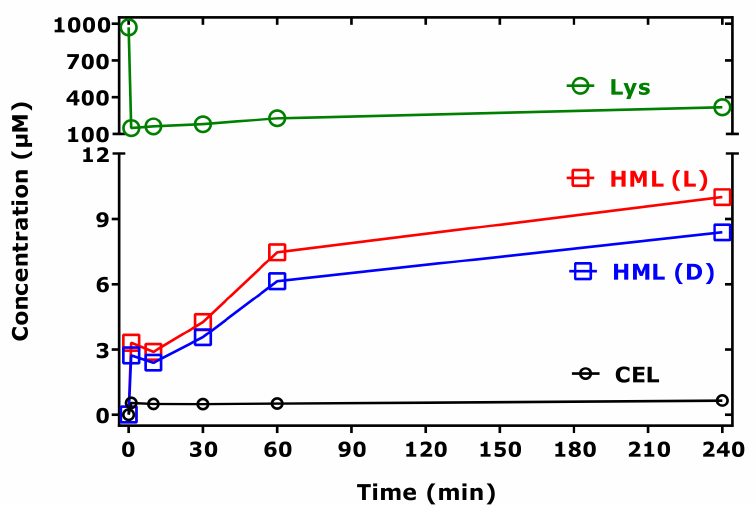
Figure 6. Time-course of the formation of HML and CEL and of remaining Lys in reaction mixtures of Lys methyl ester (1 mM) and MGO (5.8 mM) in 100 mM buffer, pH 7.4, at 37 ◦ C. (L) and (D) indicate L-5-hydroxy-lysine and D-5-hydroxy-lysine (each 20 µ M), which were used as the internal standards for HML. See also Figure 7.